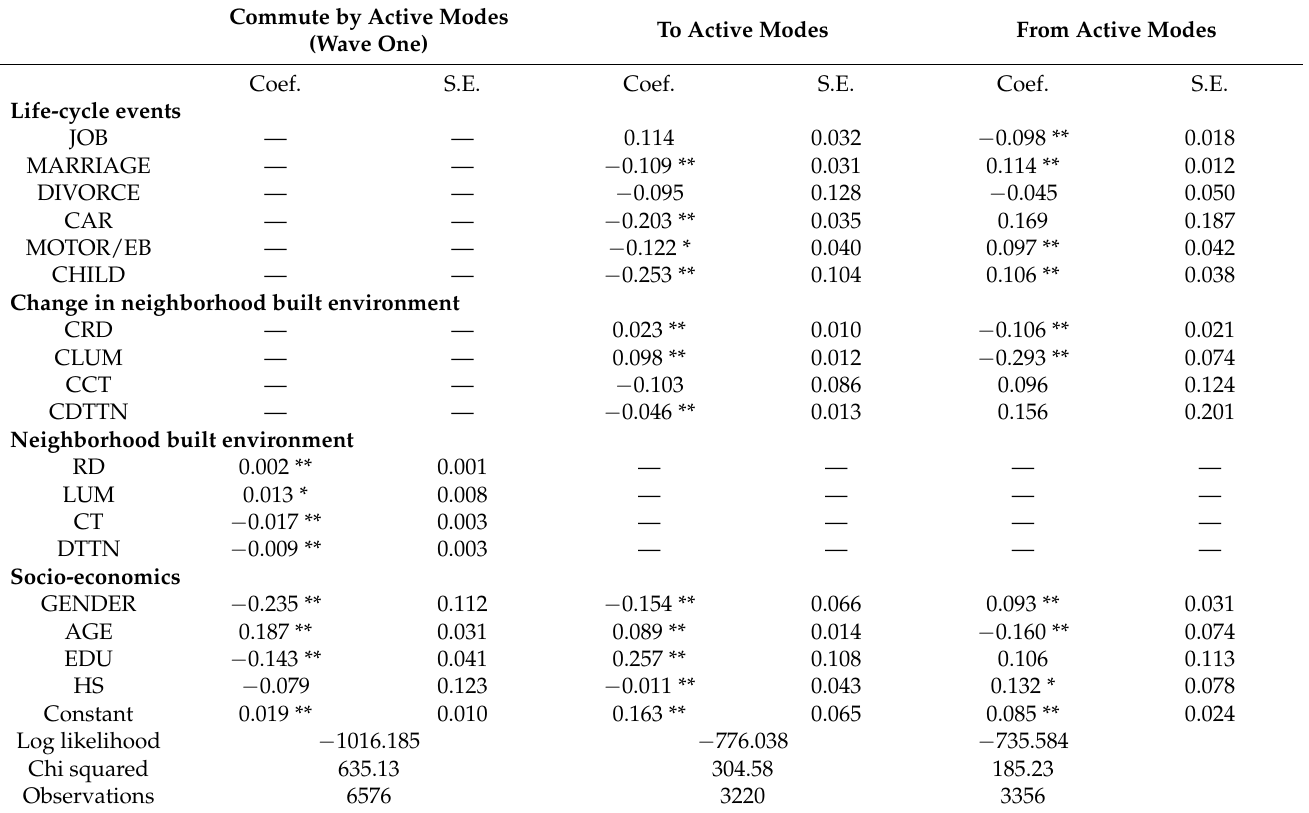
Table 4. Logistic models of active commuting and switches to and from this position. Commute by Active Modes To Active Modes From Active Modes (Wave One) Coef.